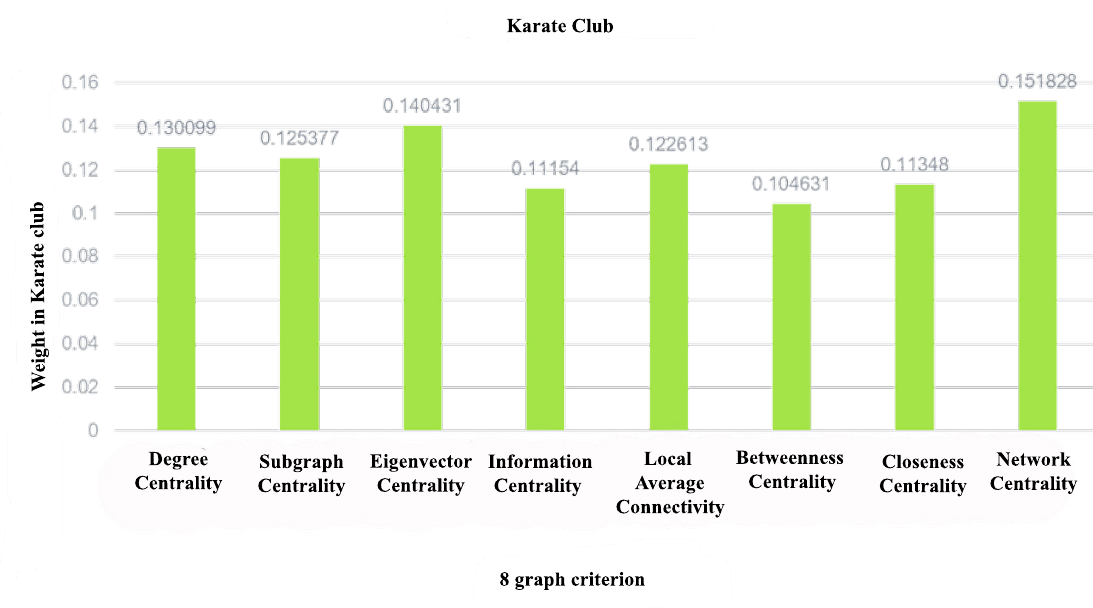
Figure 6. The average weighting of each criterion in the calculation of the important-score criterion by performing a 10-fold cross-validation on the DINGA system in the karate